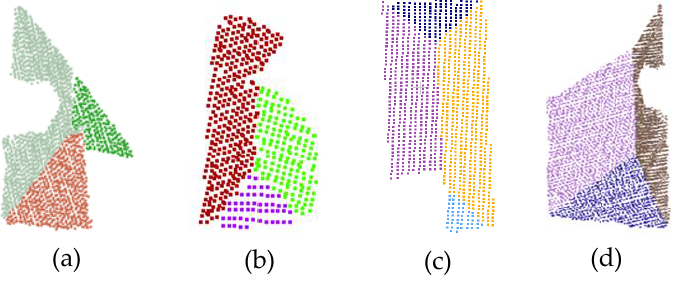
Figure 7. Some ambiguous structures ( a – d ) need to be refined.